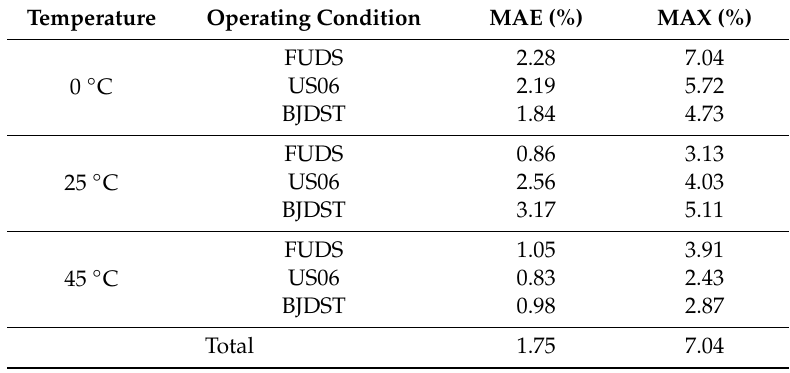
Table 5. SOC estimation results under mixed charge-discharge conditions.